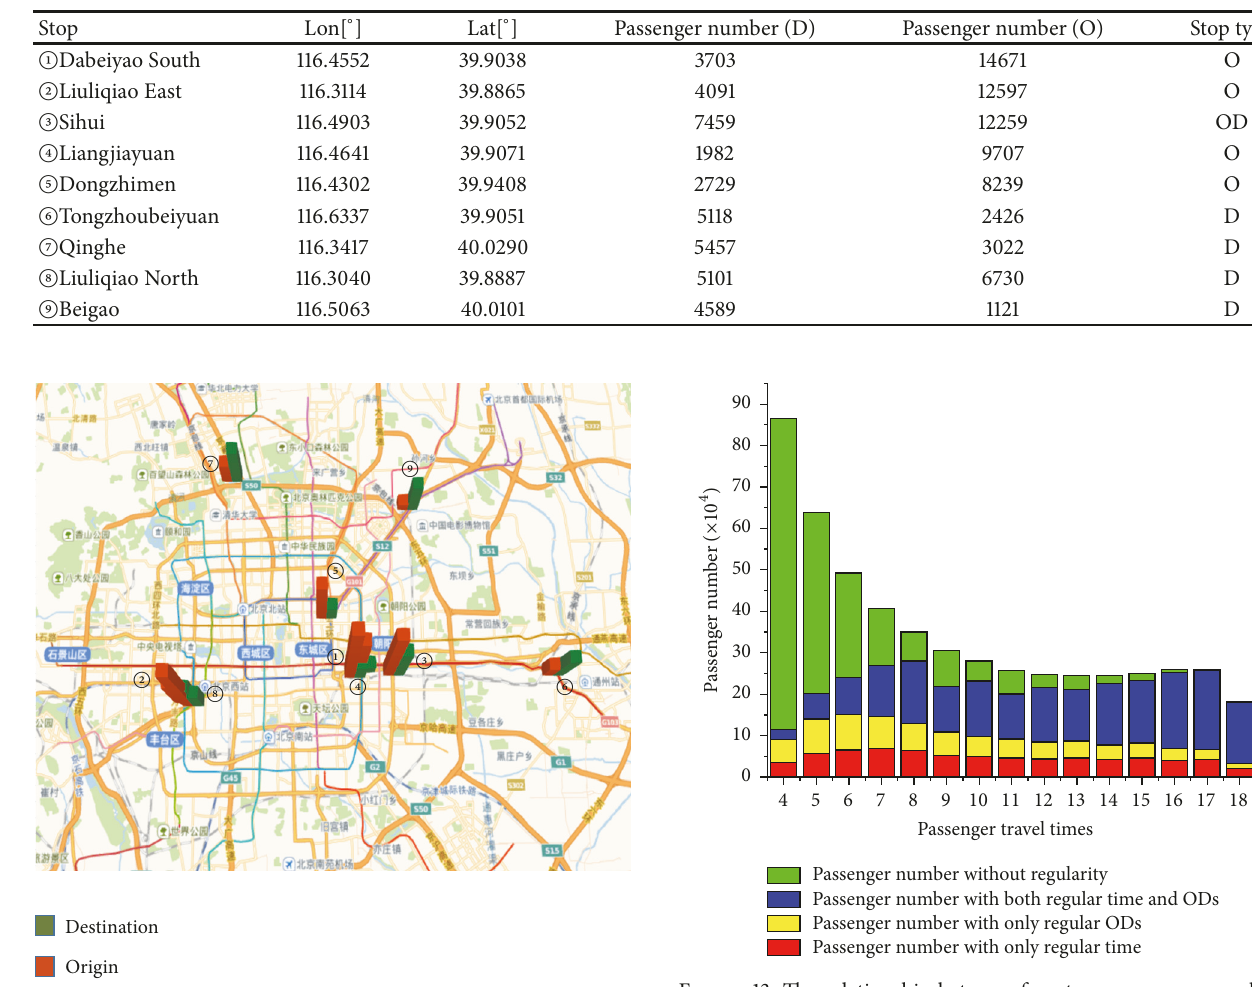
Table 2: detail data for the top five origin stops and destination stops with the most passengers in the evening.